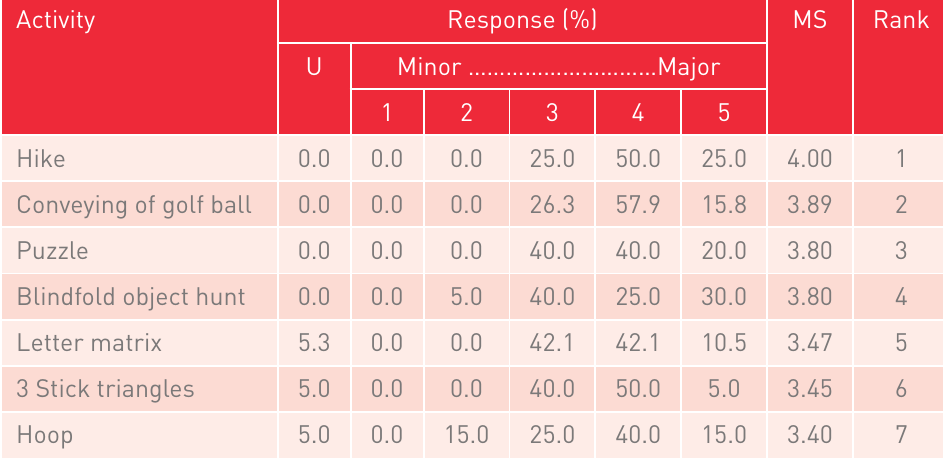
Extent to which participants benefited from the team building